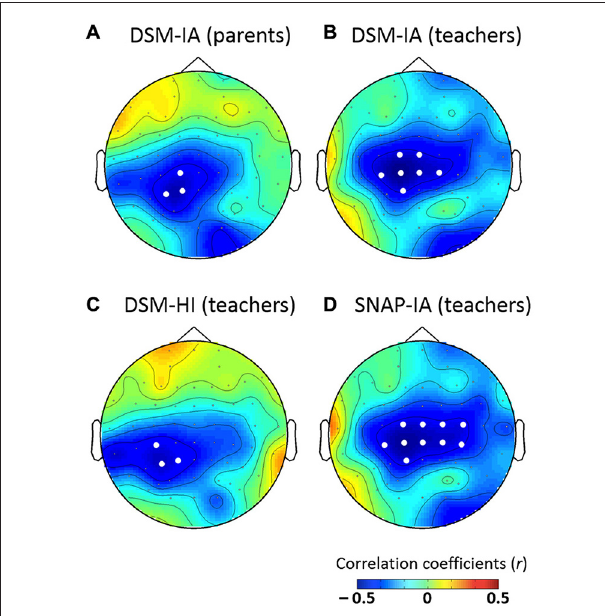
FIGURE 6 | Topographic maps for the significance of correlation between P3a with (A) DSM-IA (parents), (B) DSM-IA (teachers), (C) DSM-HI (teachers), and (D) SNAP-IA (teachers). White dots indicate electrodes with significant correlations ( p s <